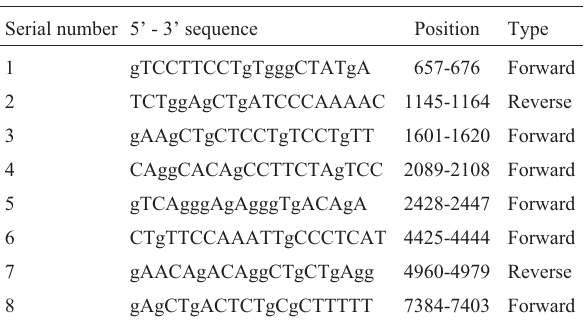
Table 2 - Additional primers designed for Primer